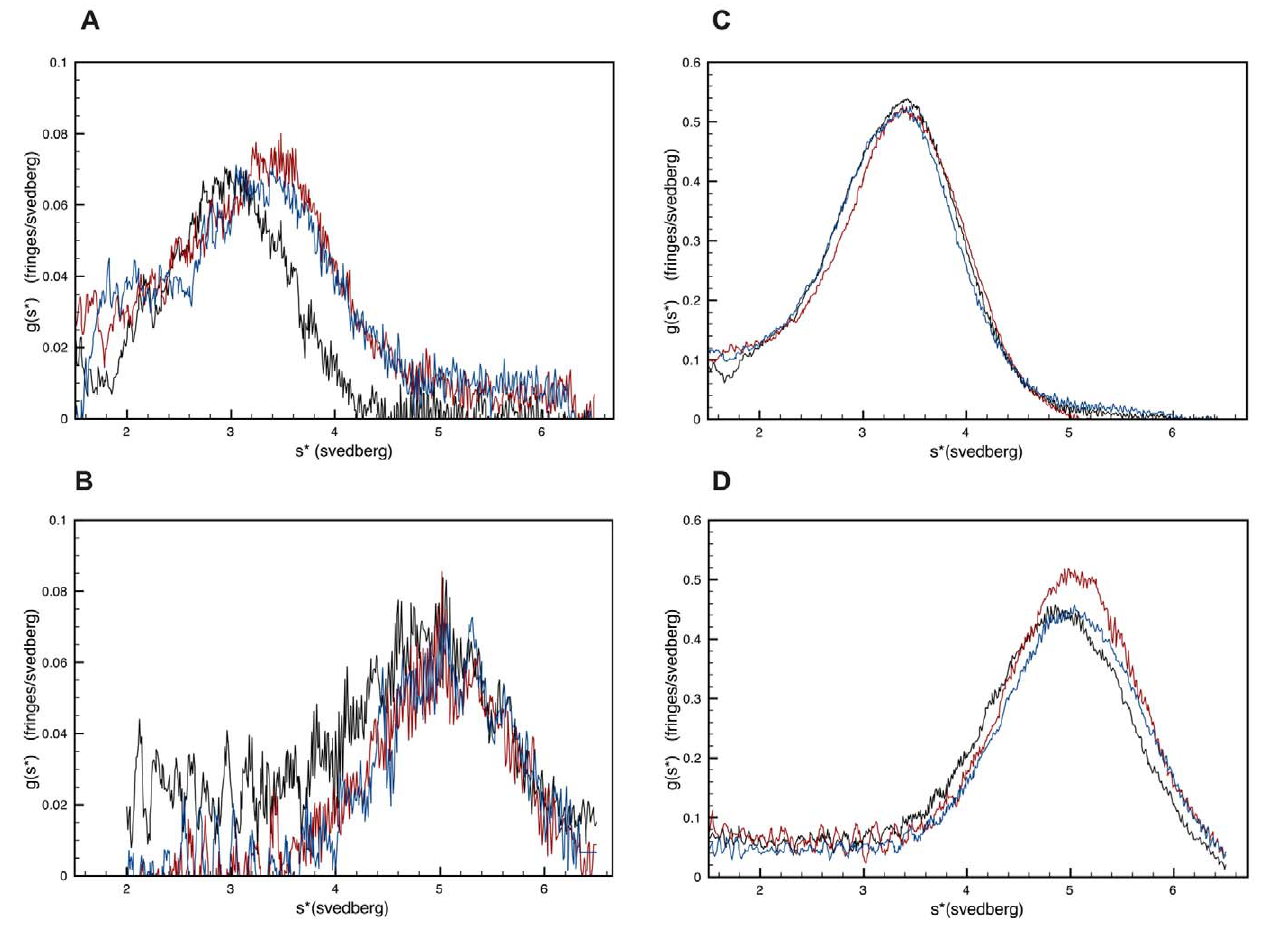
Figure 5. Sedimentation velocity. Each panel shows the sedimentation velocity profile using the whole boundary g(s*) approach of Stafford [28] for apoWrbA (black), WrbA + 50 m M FMN (red), and WrbA + 50 m M FMN + 0.5 mM NAD (blue). A, 3 m M total protein (monomer) at 5 u C; B, 3 m M total protein (monomer) at 20 u C; C, 20 m M total protein (monomer) at 5 u C; D, 20 m M total protein (monomer) at 20 u C.